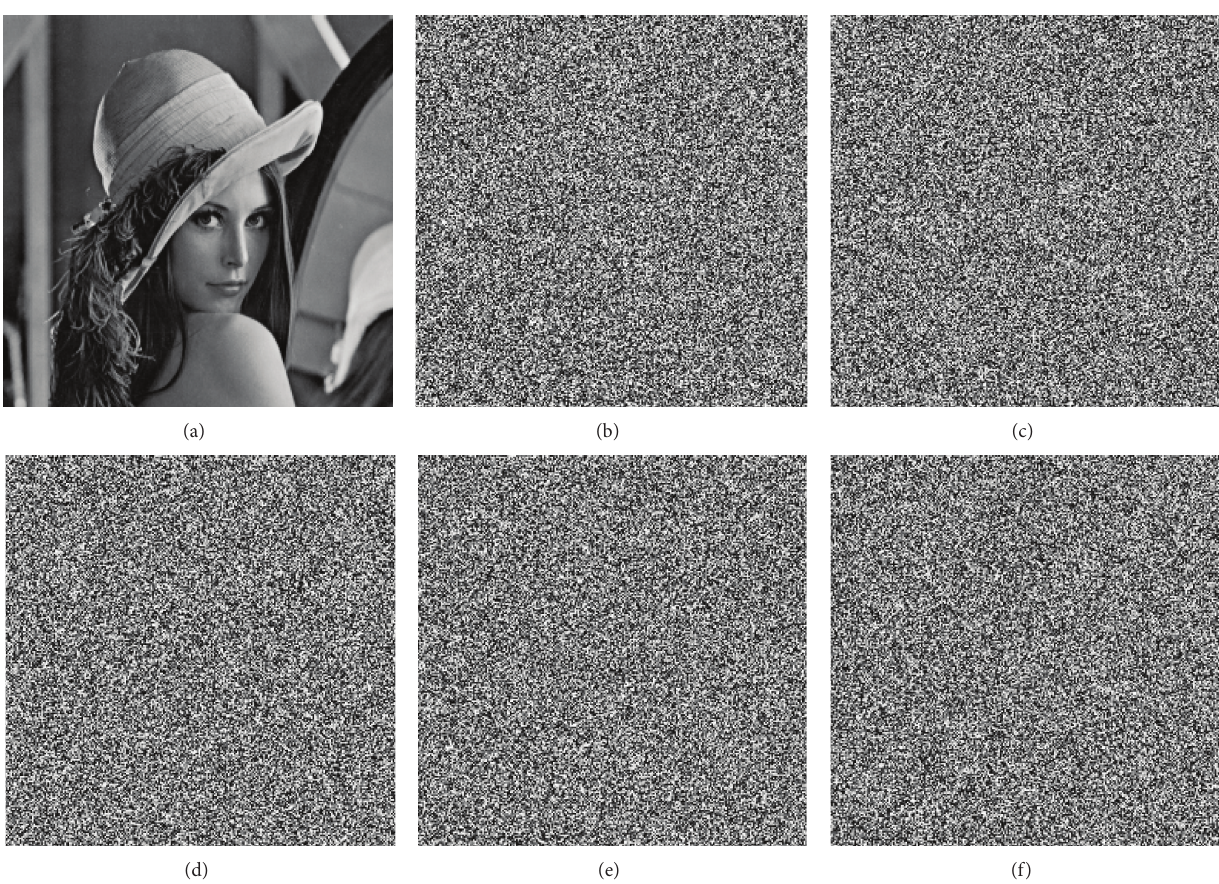
Figure 2: Encryption and decryption: (a) plain-image of Lena, (b) cipher-image, (c) decrypted image with key 𝑥 0 + 10 −14 , (d) decrypted image with key 𝑦 0 + 10 −14 , (e) decrypted image with key 𝑧 0 + 10 −14 , and (f) decrypted image with key 𝑝 = 31